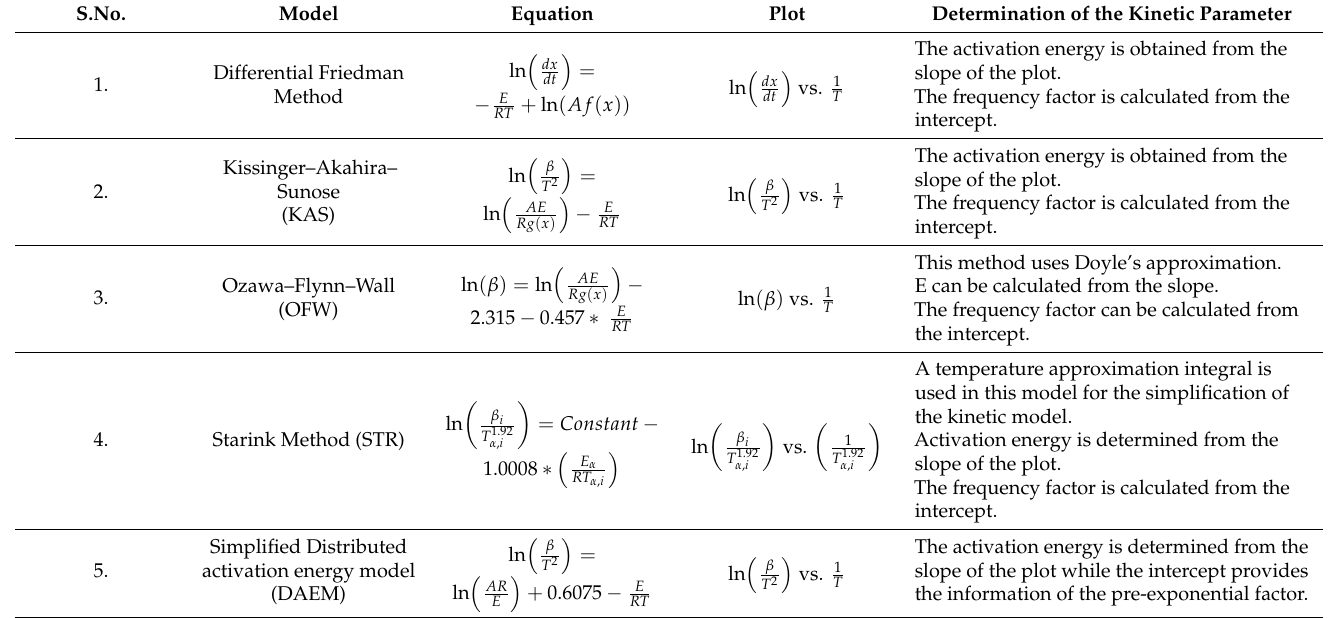
Table 1. Kinetic modelling equations for the iso-conversional model-free methods. Reprinted with permission from